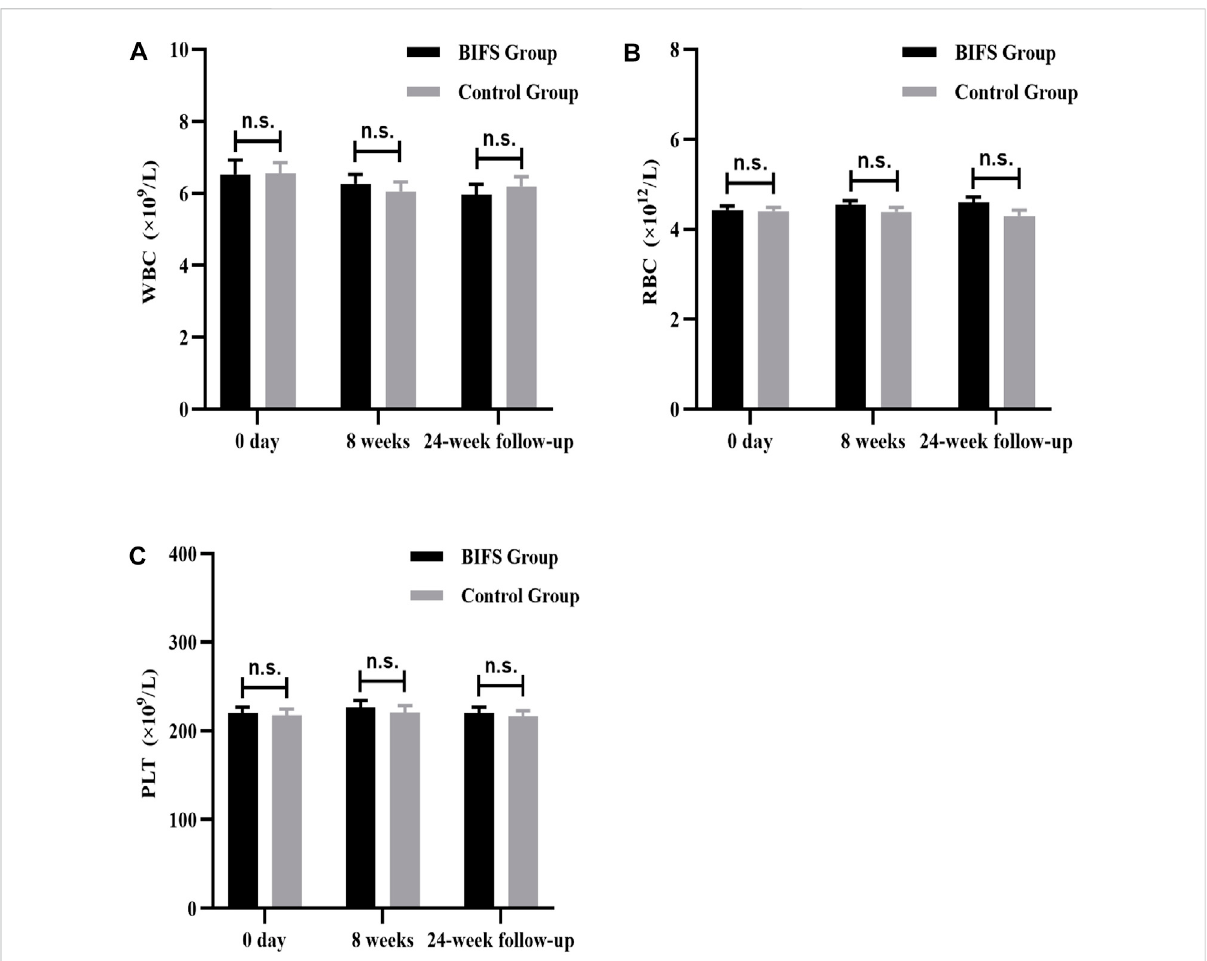
FIGURE 8 Routinebloodtests,aftereighttreatmentweeks,andat24-weekfollow-up. (A) WBC, (B) RBC, (C) PLT.n.s.,nostatisticallysigni fi cantdifference, * p < 0.05, ** p <